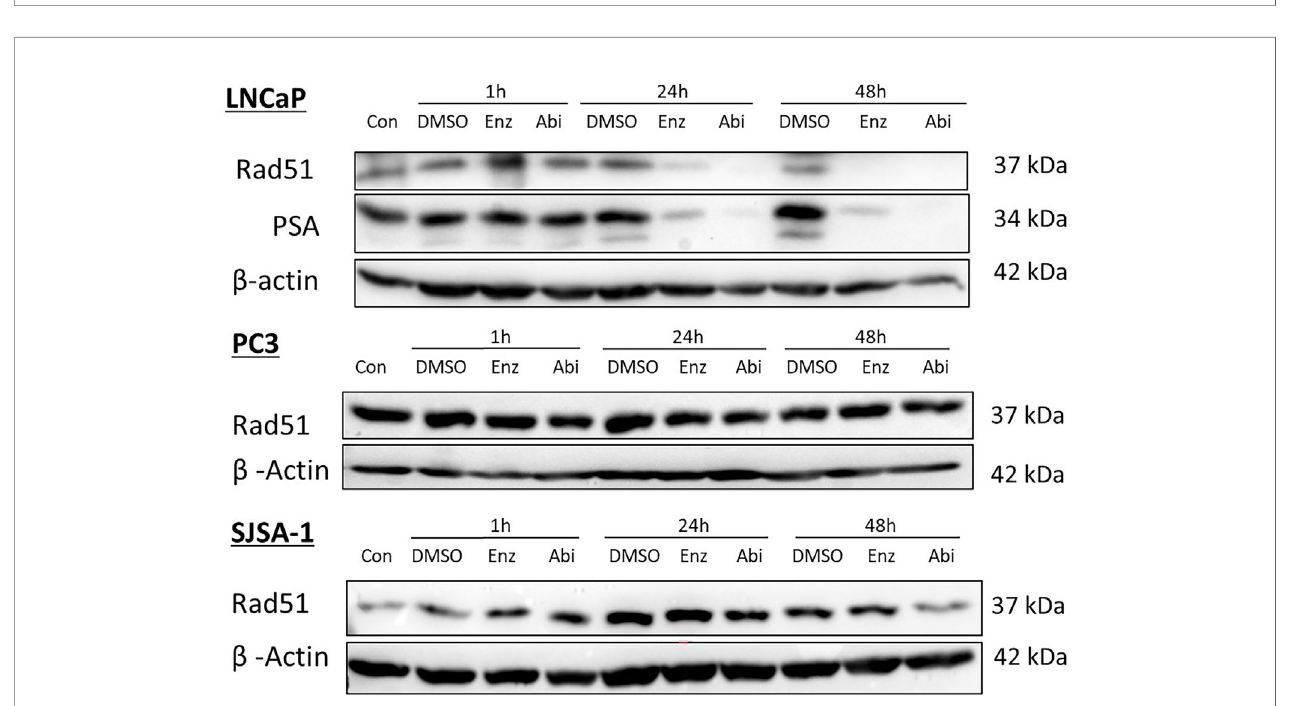
FIGURE 7 | Impact of Abiraterone and Enzalutamide on RAD51 and PSA protein expression in AR-sensitive LNCaP prostate model, AR-insensitive PC3 prostate model and osteoblastic bone model SJSA-1. All models were treated with 10 m M Abiraterone, Enzalutamide or DMSO. Samples were then harvested 1, 24- and 48- hours post-treatment and expression levels measured via Western blot. b -Actin was used as a loading control. (n=3).